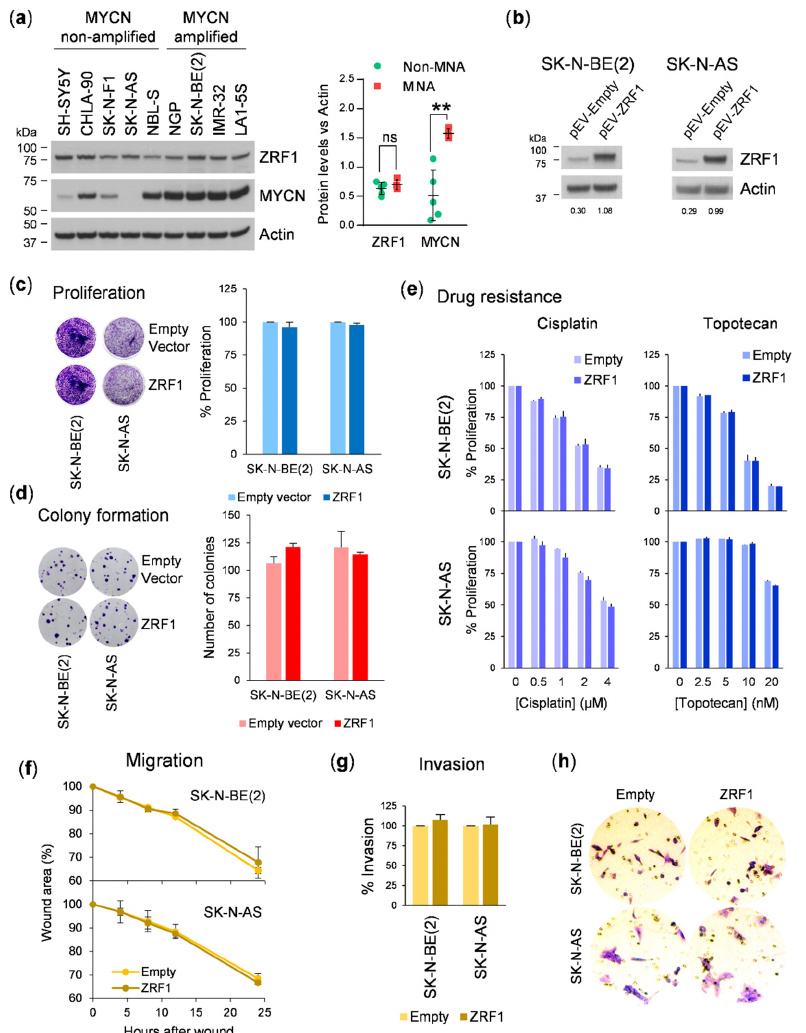
Figure 3. ZRF1 overexpression does not enhance neuroblastoma cell line aggressiveness. ( a ) Left, protein expression analysis of ZRF1 and MYCN by Western blot of a 9-neuroblastoma cell line panel. Right, densitometry quantification. ( b ) Western blot validation of ZRF1 overexpression in SK-N-BE(2) and SK-N-AS cell lines at 96h post-transduction. ( c ) Proliferation assay of neuroblastoma cell lines overexpressing ZRF1 compared to empty-vector (pEV-empty)-transduced cells. ( d ) Colony formation assay of neuroblastoma cells overexpressing ZRF1 . Graph represents the average of three independent experiments, n = 3 per condition. ( e ) Cisplatin and topotecan resistance assay of ZRF1 -overexpressing cell lines. Cells were treated for 72 h at the indicated doses, and proliferation was assessed by crystal violet staining. ( f ) Wound-healing assay in neuroblastoma cells overexpressing ZRF1 . Graphs represent percentage of the wound area at the indicated times, normalized to time = 0. ( g ) Invasion assay of ZRF1 overexpressing cells through a collagen barrier for 16 h. Invasive cells were detected and quantified by crystal violet staining. ( h ) Representative microscopic pictures of crystal violet-stained invasive cells. ns means non-significant; ** means p < 0.01.